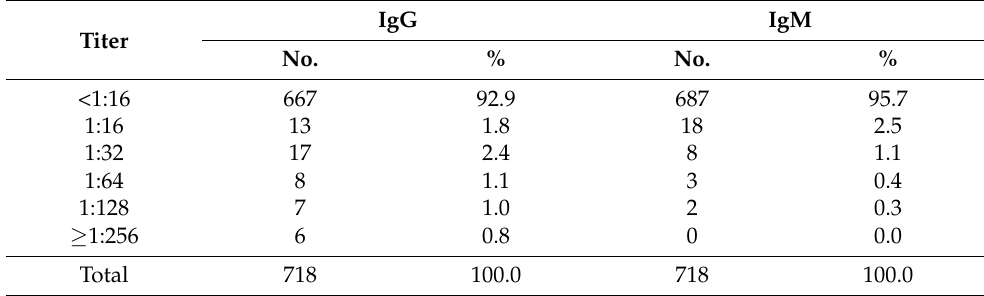
Table 1. Serologic results for Orientia tsutsugamushi antigen among National Park Office forestry workers in South